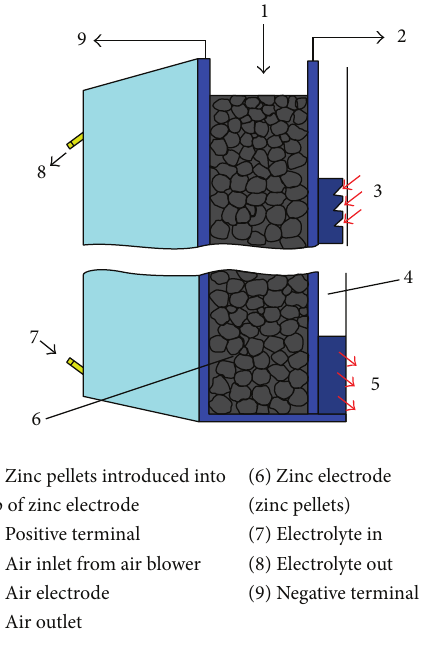
Figure 1: Metallic power company cell.